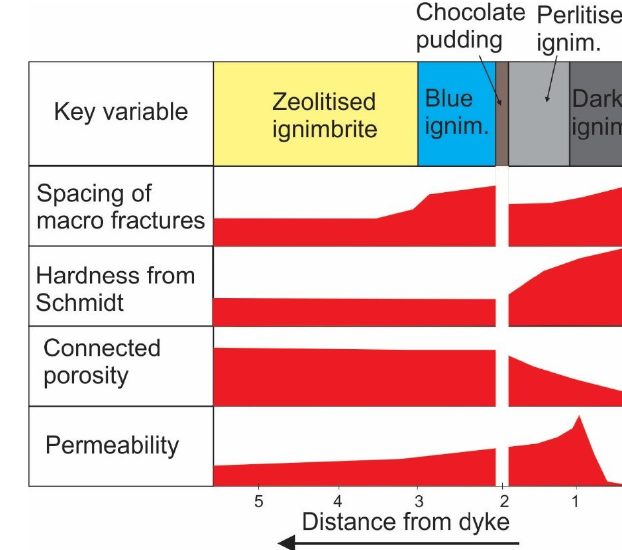
Figure 8: Summary of key results showing conceptu- alised relative results of each lithology, the height of the red area shows an approximation of the relative magni- tude of the key variables as they change with distance from the dyke (in meters) at Hvítserkur mountain (East